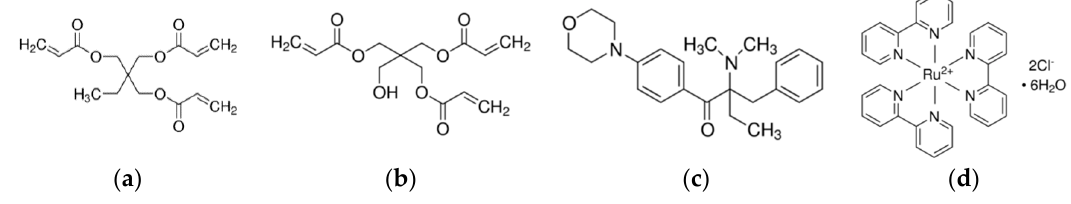
Figure 1. Chemical structures of ( a ) trimethylopropane triacrylate (TMPTA); ( b ) pentaerythritol triacrylate (PETA); ( c ) 2-benzyl-2-(dimethylamino)-4 ′ -morpholinobutyrophenone (DBMP); and ( d ) ruthenium(II) complex.